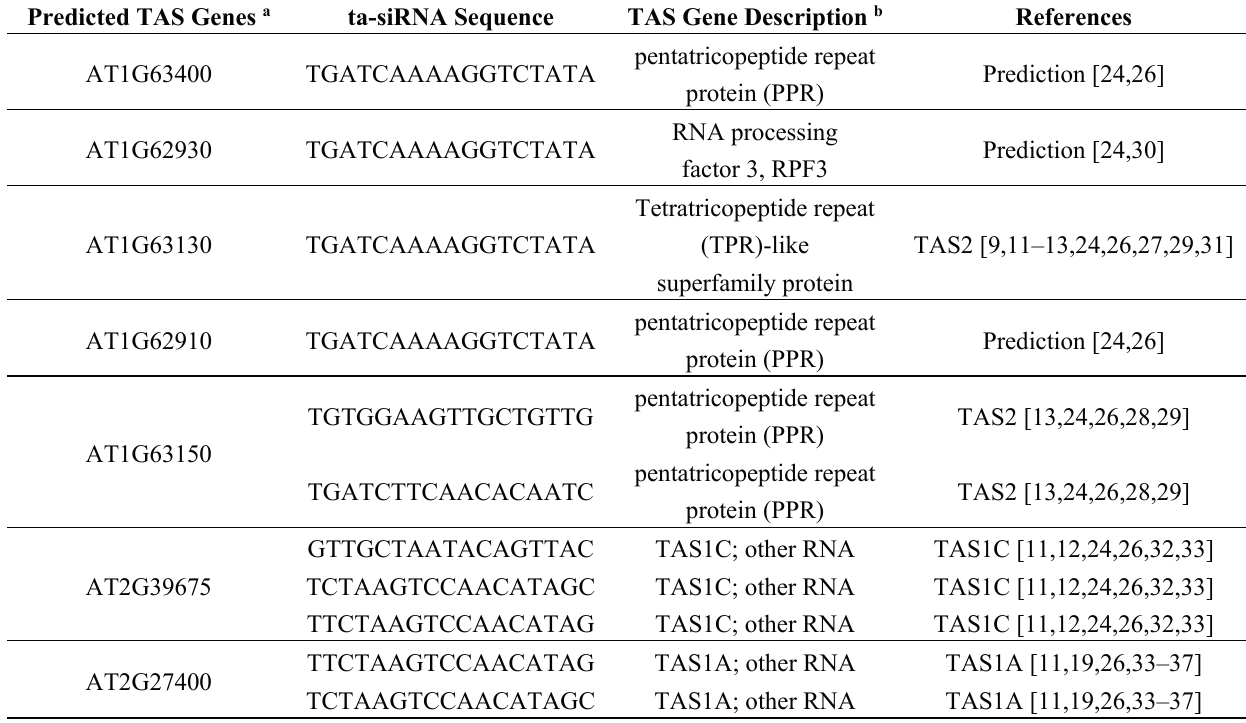
Table 1. Prediction results for A. thaliana TAS genes and